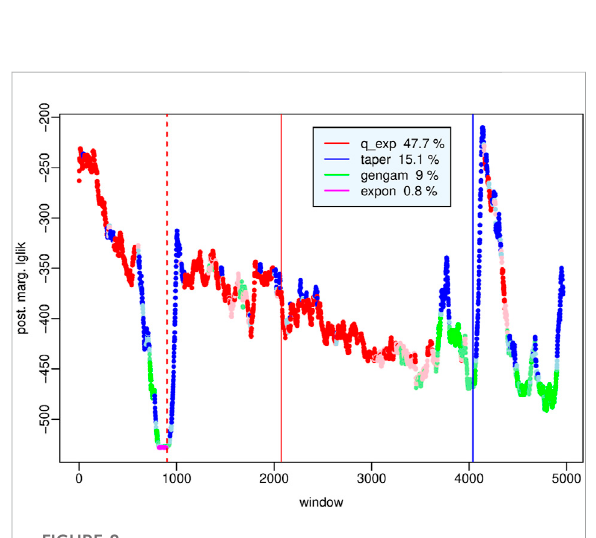
FIGURE 8 Amatrice-Norcia sequence - Posterior marginal log- likelihood of the probability distribution of Voronoi cell area that fi ts better than the other distributions to the dataset of each time window. The red vertical lines indicate the Amatrice ( M w 6.1) shock (dashed line) and the Norcia ( M w 6.5) mainshock (solid line) respectively;theblueverticallineindicatestheCapignano( M w 5.5) shock that occurred on 18 January 2017.